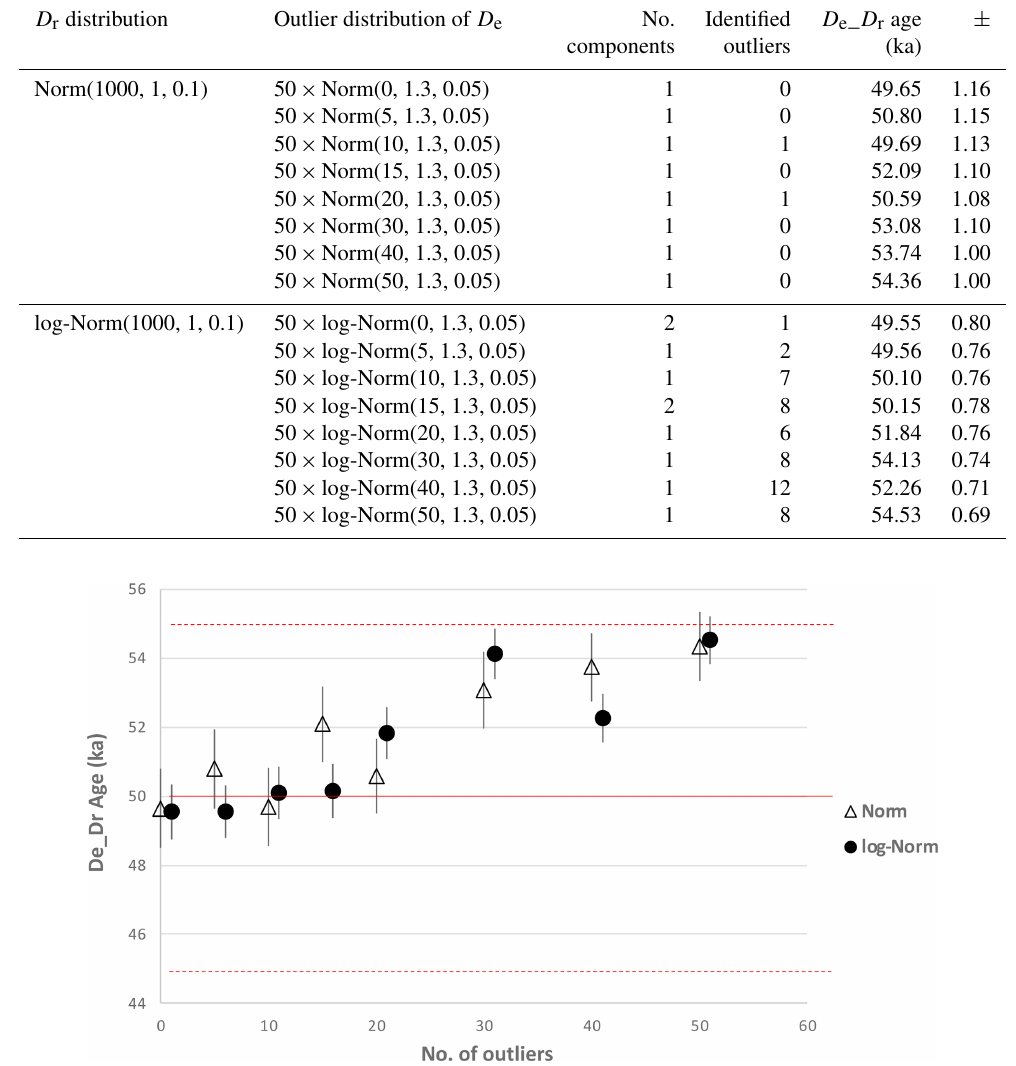
Figure 8. D e _ D r age as a function of the number of outliers added to the initial D e distribution (the expected age is 50ka, indicated by the red line). Norm and log-Norm represent the functions from which the initial D e distributions (comprising 100 values) were built. Error bars represent 95% credible intervals. Dotted lines are ±